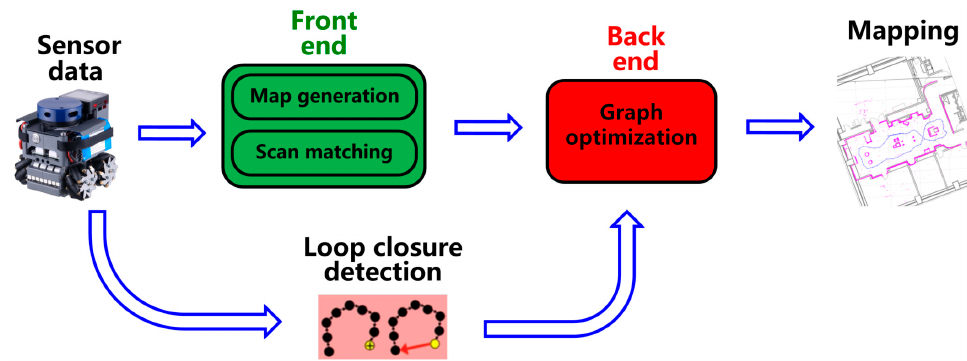
Figure 1. Framework of classic LiDAR SLAM system.